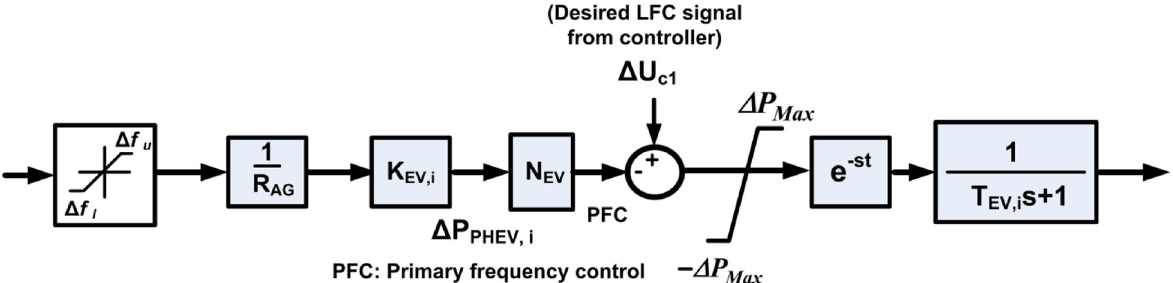
Fig. 3 PHEV aggregator